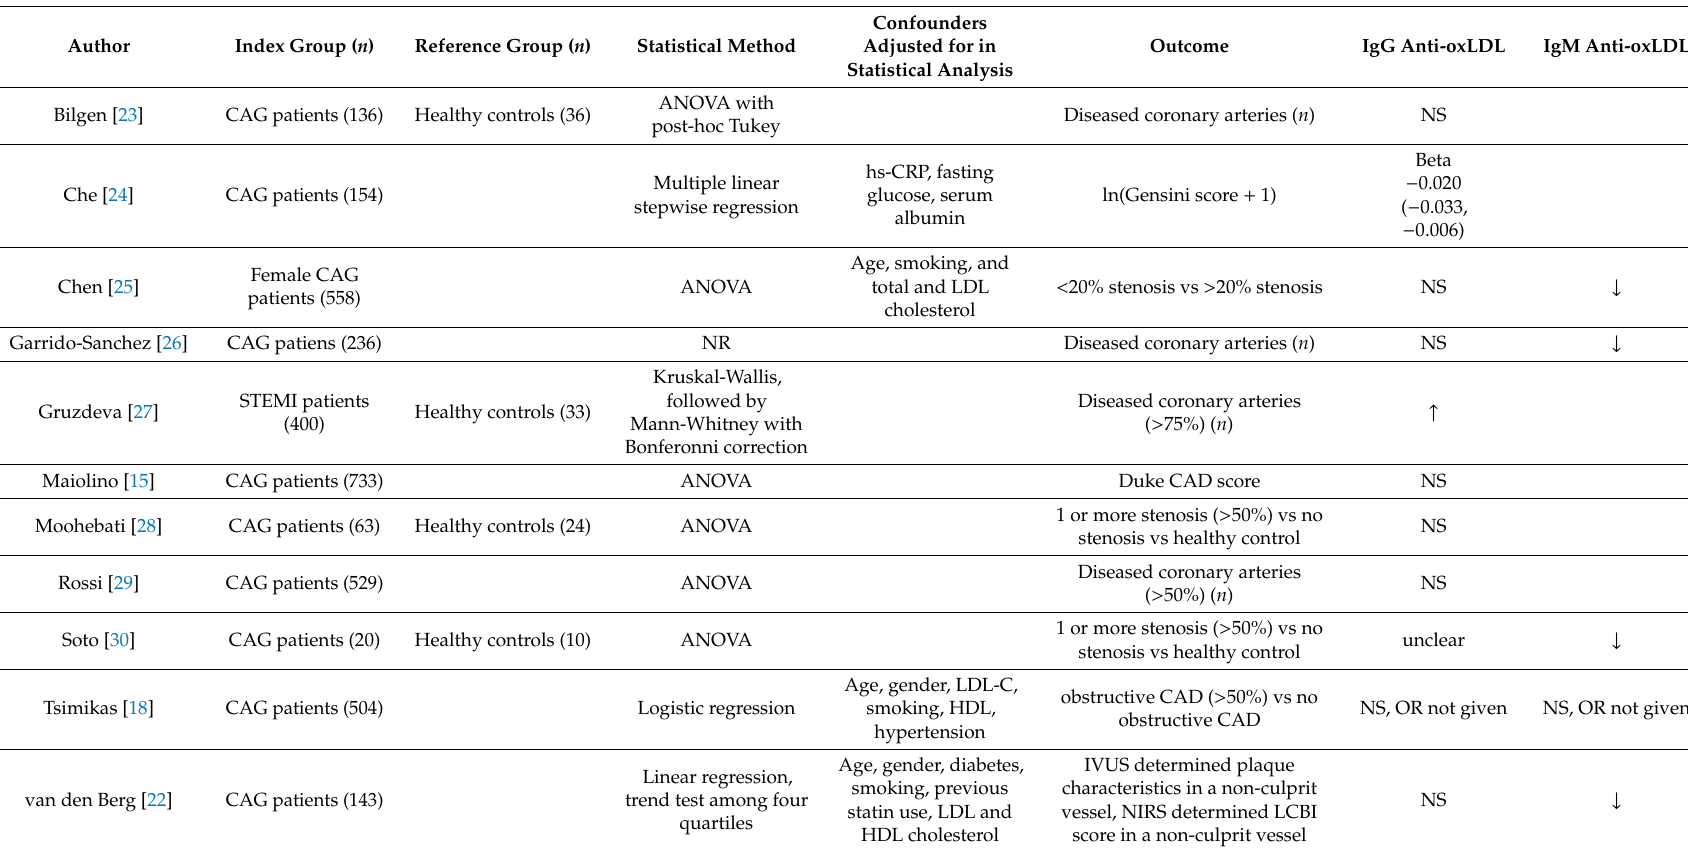
Table 2. Relationship between anti-oxidized low density lipoprotein (anti-oxLDL) antibodies and coronary artery disease assessed by coronary